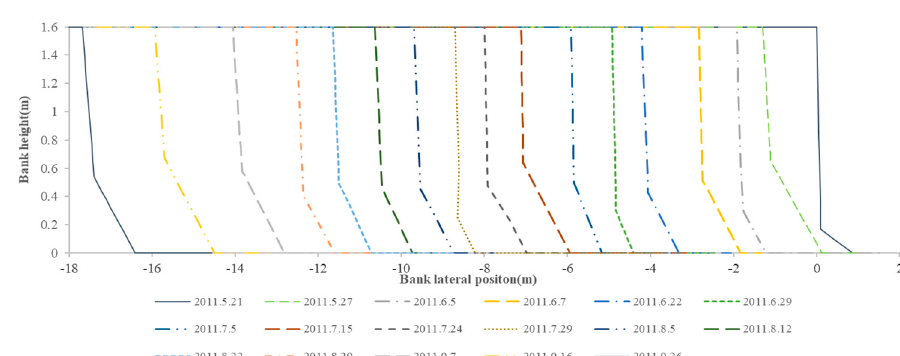
Figure 9. Collapse phases for Section 4.